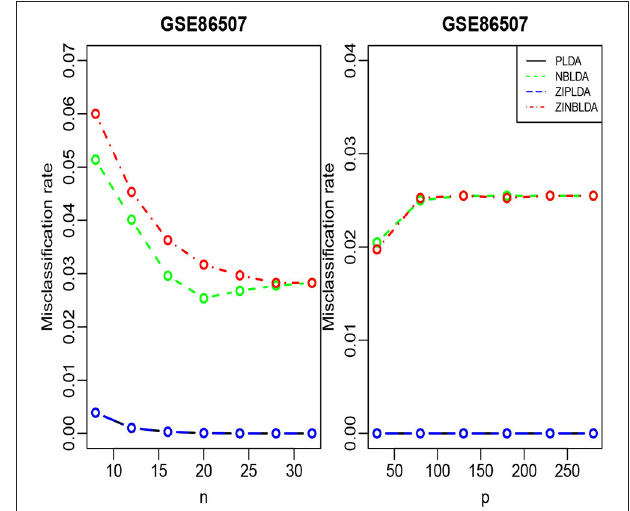
FIGURE 6 | The misclassification rates of the four methods with different probabilities of differential expression genes (Study 5). Here, σ = 0.2, p = 100, n = 8, φ = 0.5, and p 0 = 0.